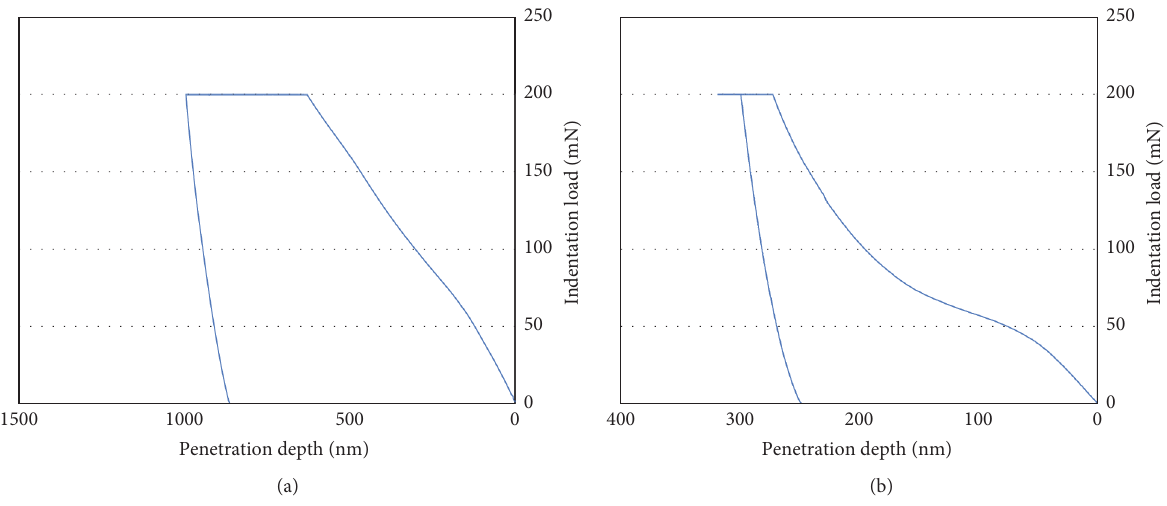
Figure 4: Force-indentation depth of (a) SPEEK and (b) PEEK via the